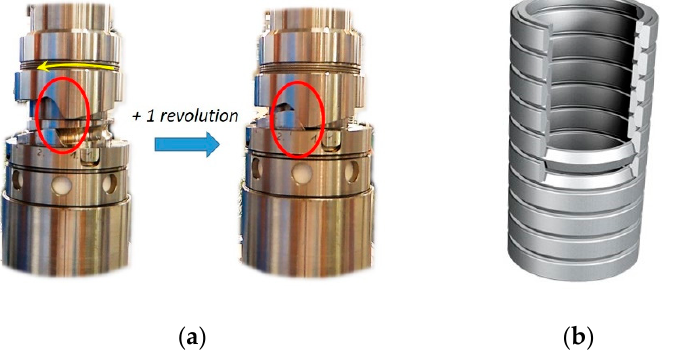
Figure 14. Examples of means to limit shock on stops in motor driven linear actuators: ( a ) Dog tooth (ball-screw mount); ( b ) Spring rings (rod mount).